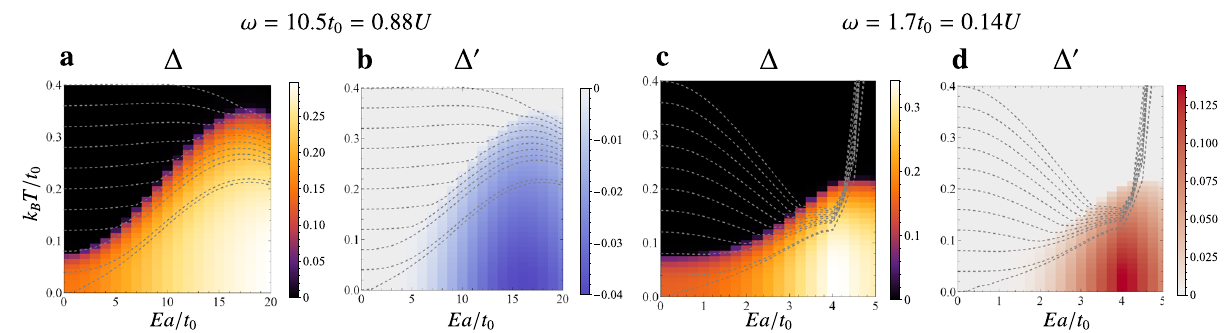
Fig. 5 Finite-temperature phase diagram. For the driving frequency ω = 10.5 t 0 = 0.88 U ( a , b ) or ω = 1.7 t 0 = 0.14 U ( c , d ), the superconducting order parameter Δ ( a , c ) and the time-reversal breaking order parameter Δ 0 (cid:6) (cid:3) i Δ temperature T . Dotted lines represent the effective temperature of the Floquet Hamiltonian when the system is quenched from E = 0 at a temperature that is the leftmost starting point of each dotted line. We take the same bare second-neighbour hopping t 0 level δ = 0.2 as in Fig.